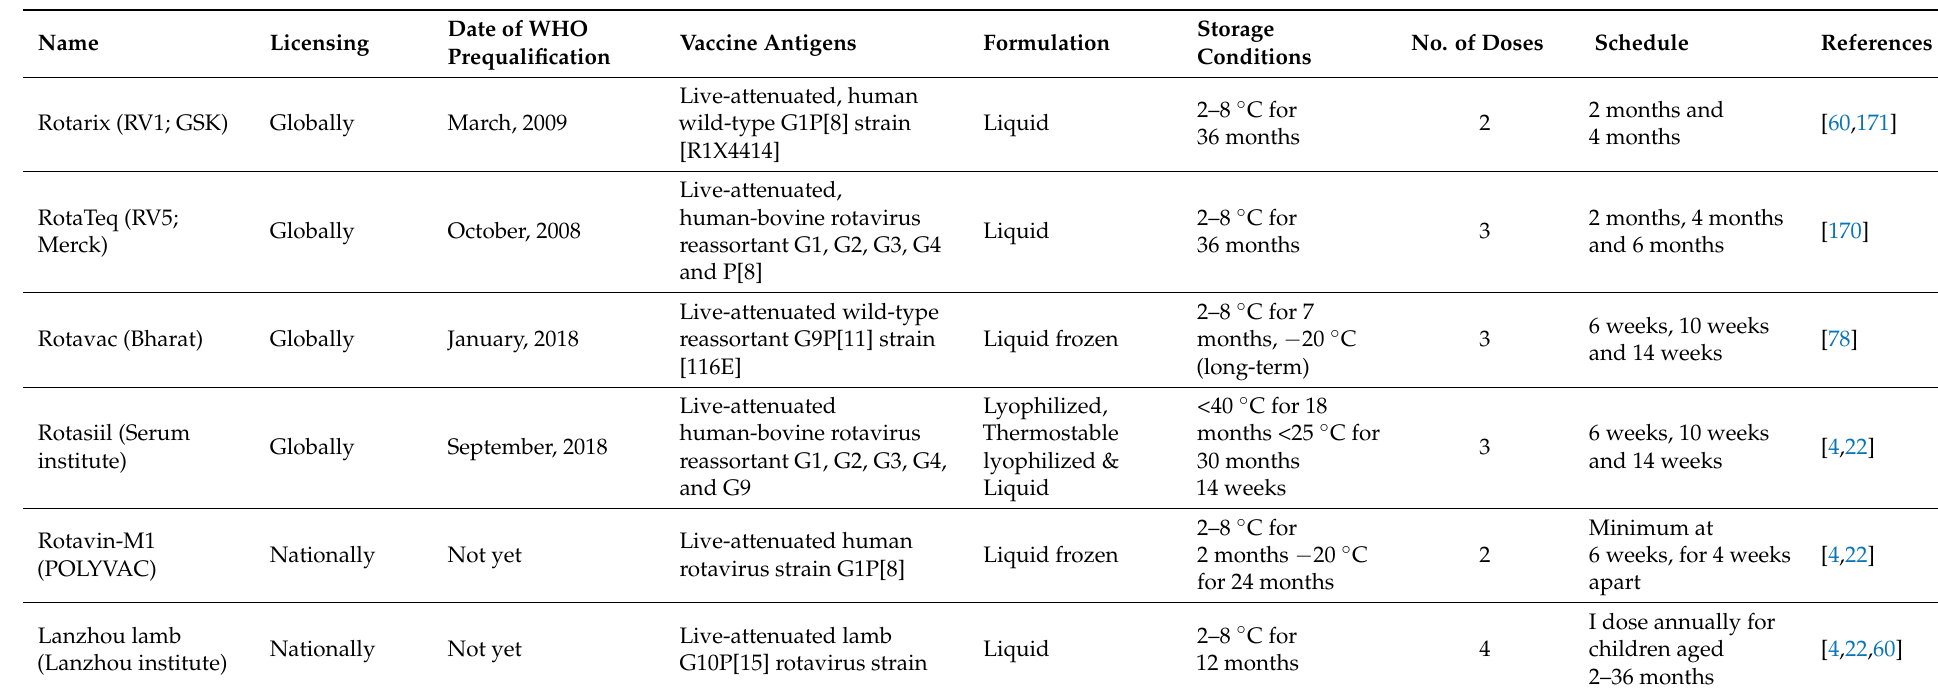
Table 2. Characteristics of rotavirus vaccines approved for